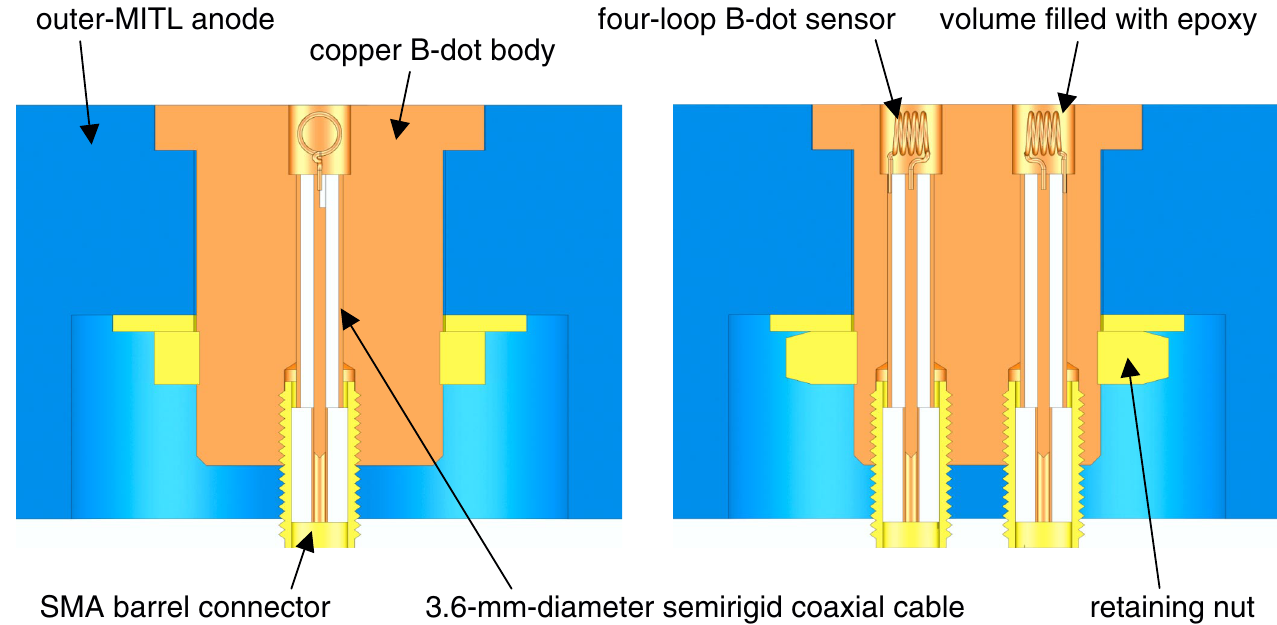
FIG. 2. (Color) Two cross-sectional views of the differential-output B -dot current monitor that is fielded on the outer MITLs of the Z accelerator. Not shown here is the 0.005-mm-thick nichrome foil that is placed over the epoxy-filled volumes. The foil shields the epoxy and B -dot sensors from the high electric field in the MITL’s anode-cathode